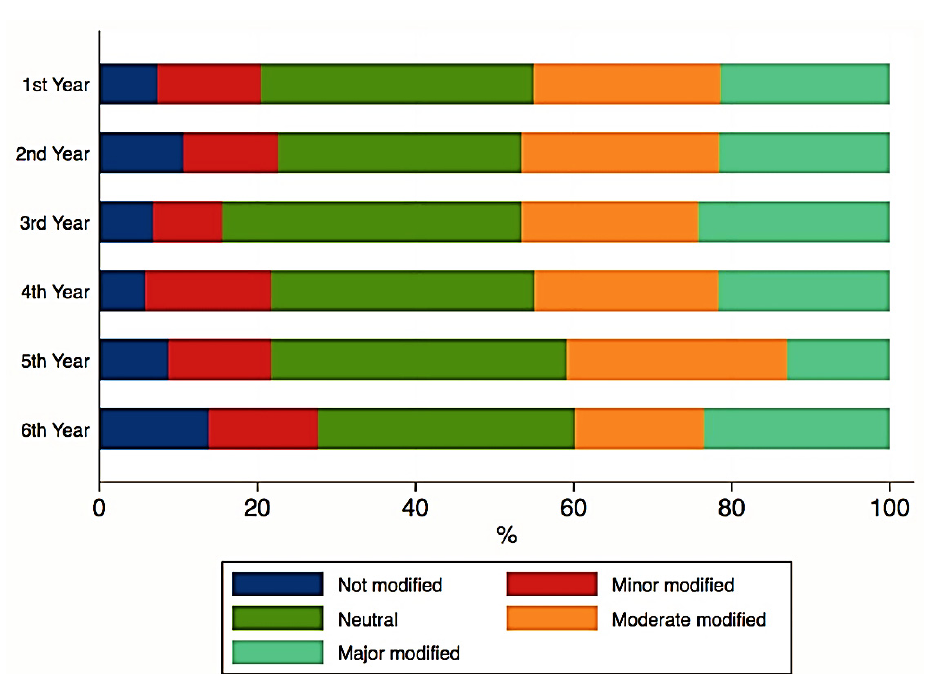
Figure 2. Academic online teaching.